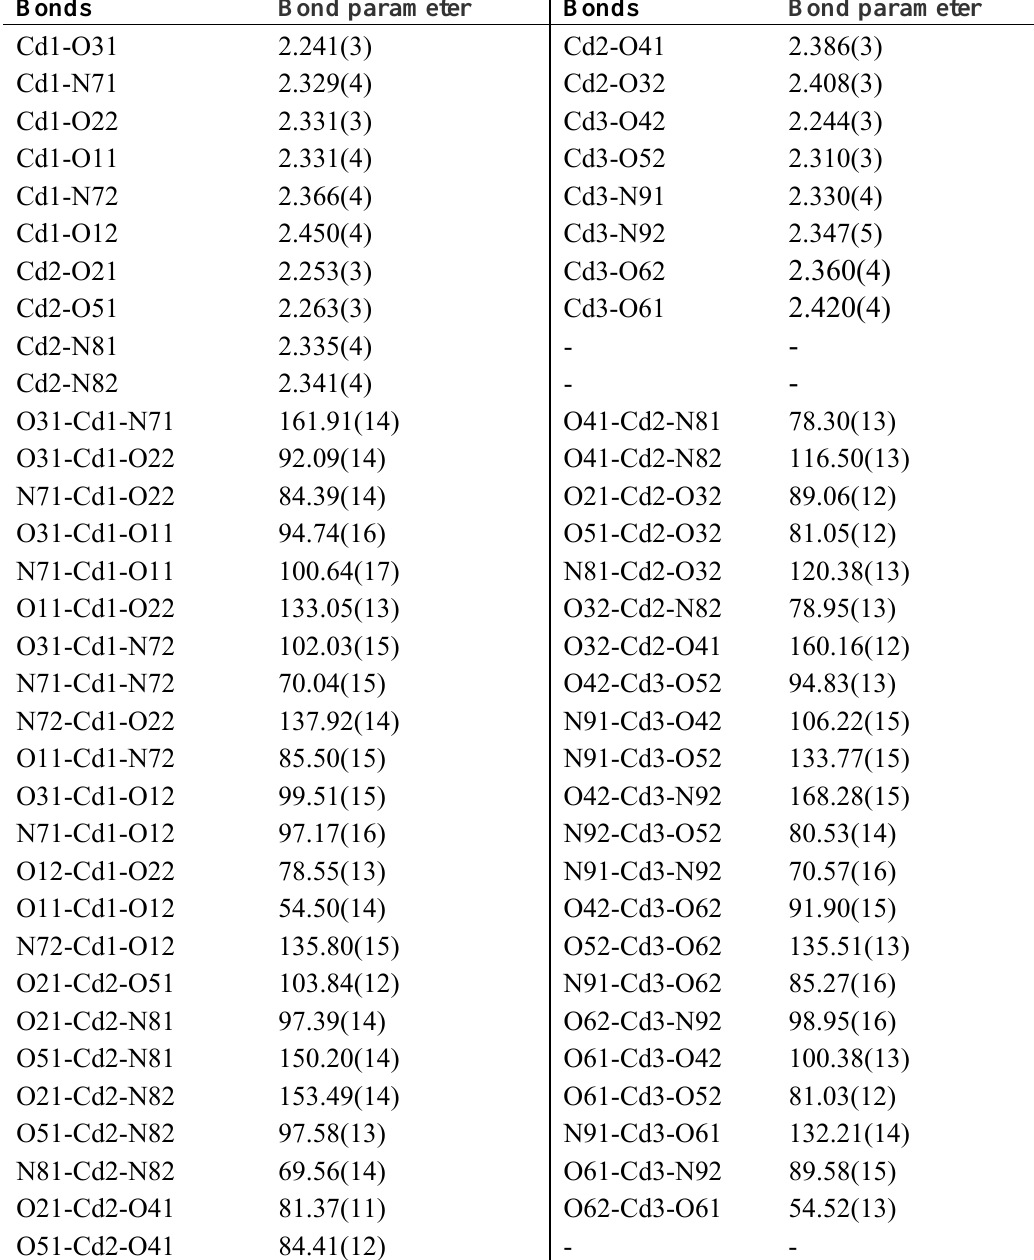
Table 2. Selected bond lengths (Å) and angles ( ° ) for the Cd (II)